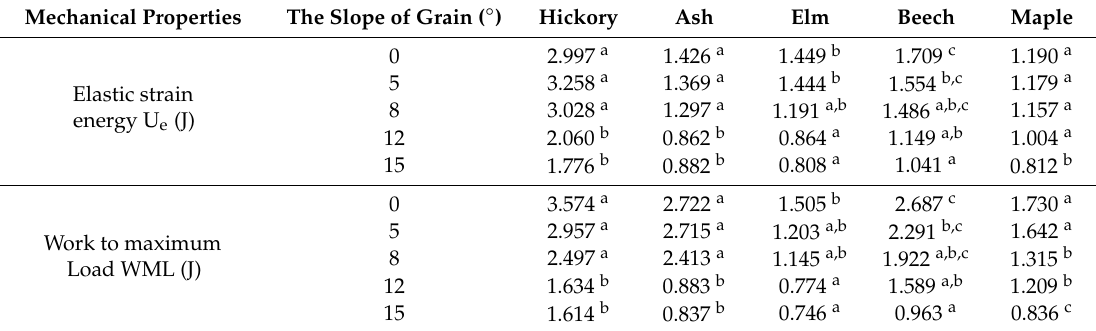
Table 3. Mechanical properties of analyzed wood species. Same letter designations in particular columns mean no statistically significant di ff erences between